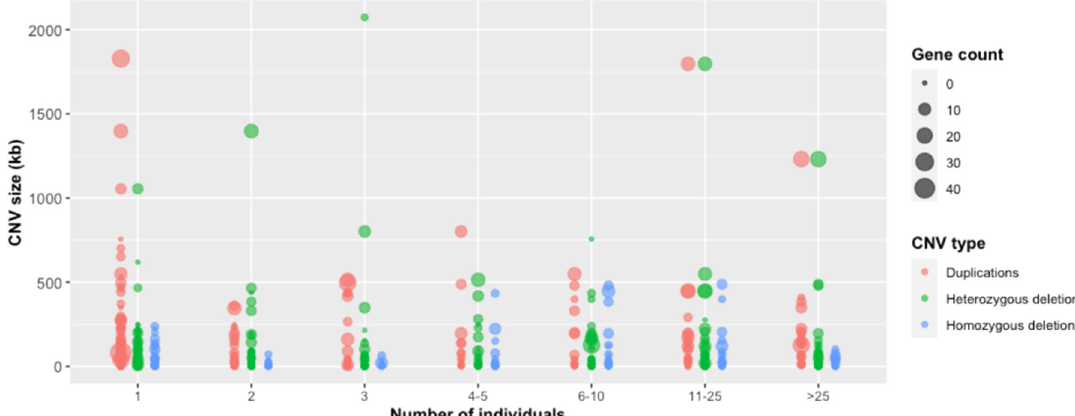
Fig. 4 CNV length, gene content and frequency distributions. CNVs were plotted according to event type (color), size ( y -axis), frequency in the Tunisian population ( x -axis, number of individuals), and number of RefSeq genes affected (circle size).